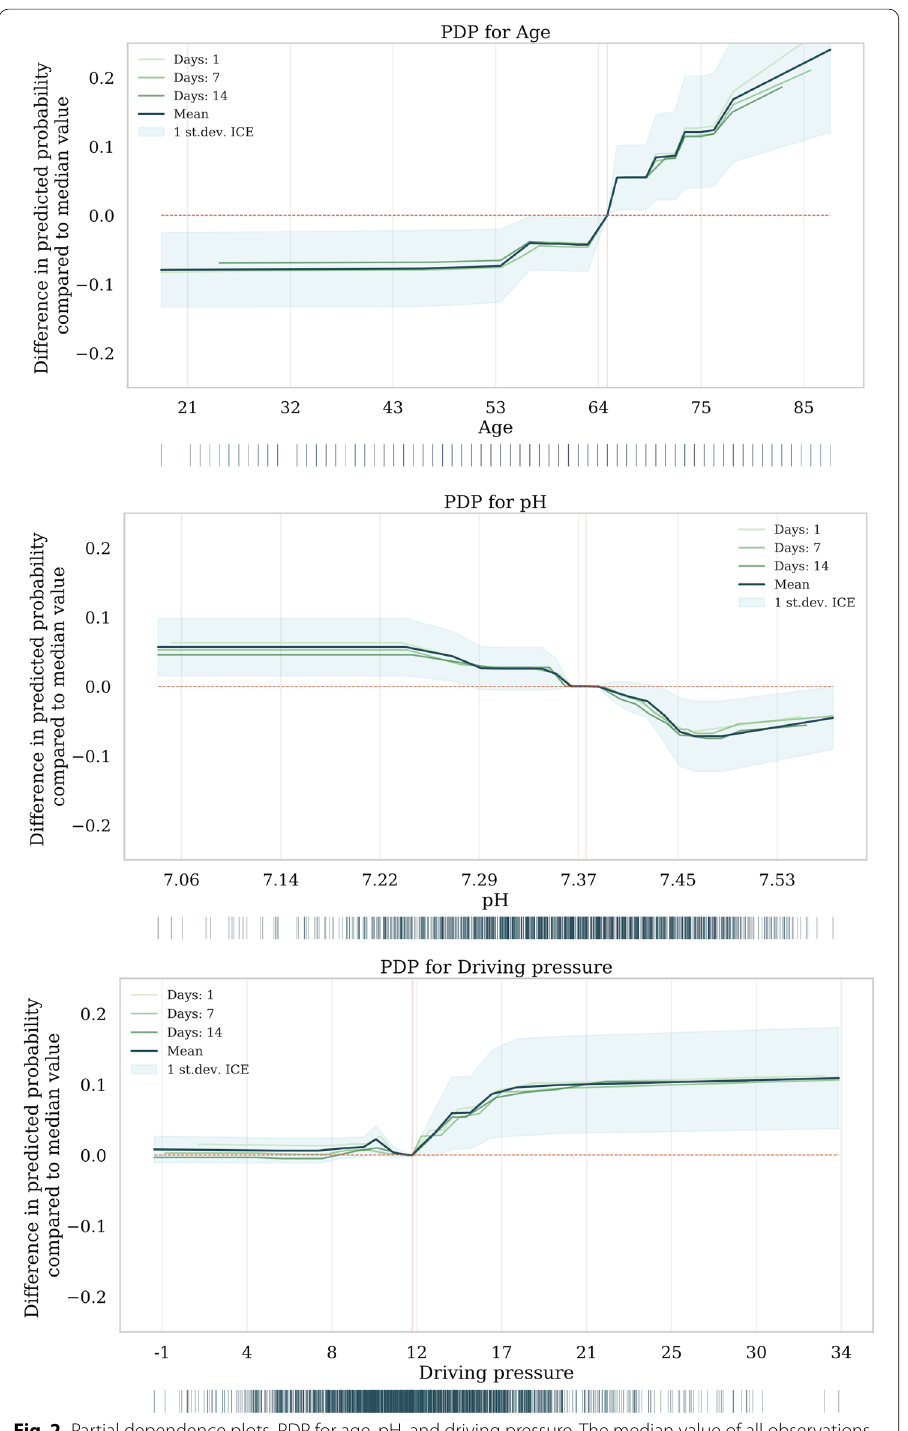
Fig. 2 Partial dependence plots. PDP for age, pH, and driving pressure. The median value of all observations is indicated with a red vertical